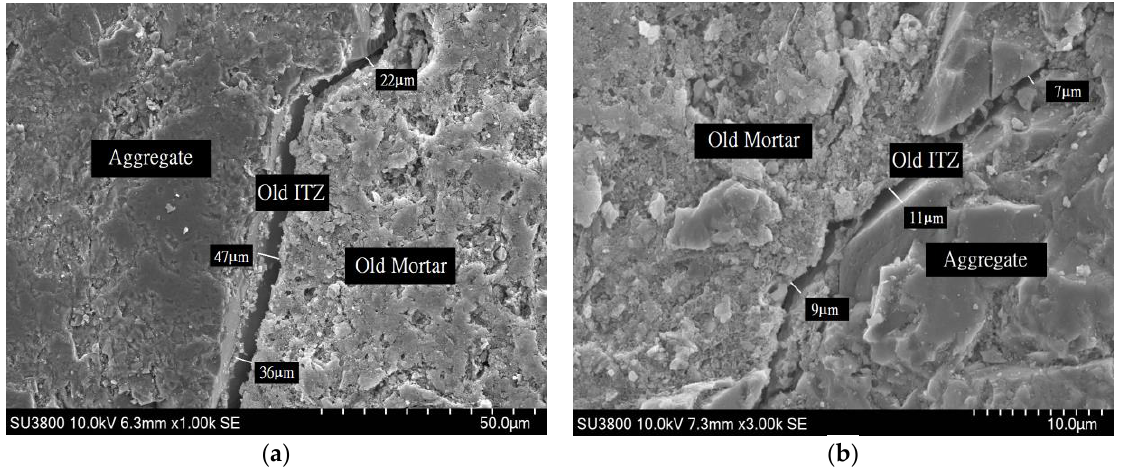
Figure 16. Scanning electronic microscope in the interfacial transition zone (ITZ) of different RCAs: ( a ) CRP-b and ( b ) CRP-bs.